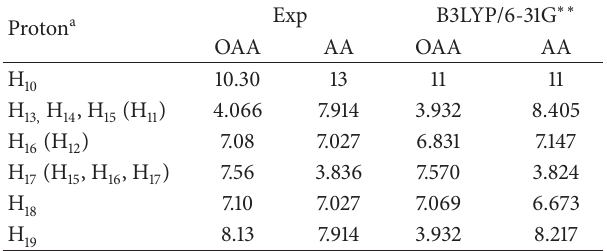
Table10:NaturalatomicchargesofO-Anisicacid(OAA)andAnisic acid (AA) calculations performed at the B3LYP/6-31G ∗∗ level of